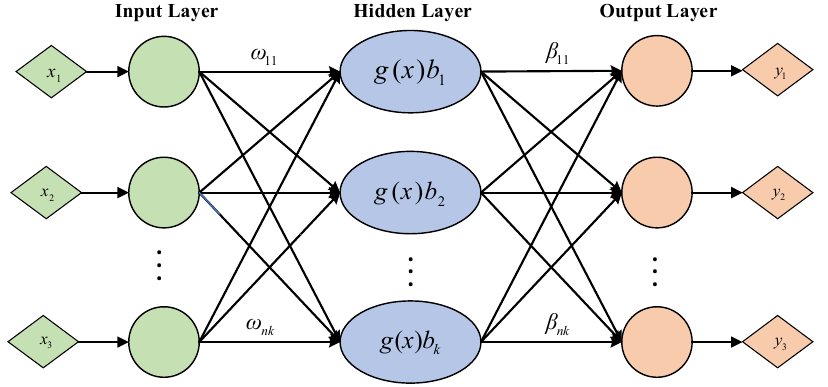
Figure 5. Extreme learning machine (ELM) model.